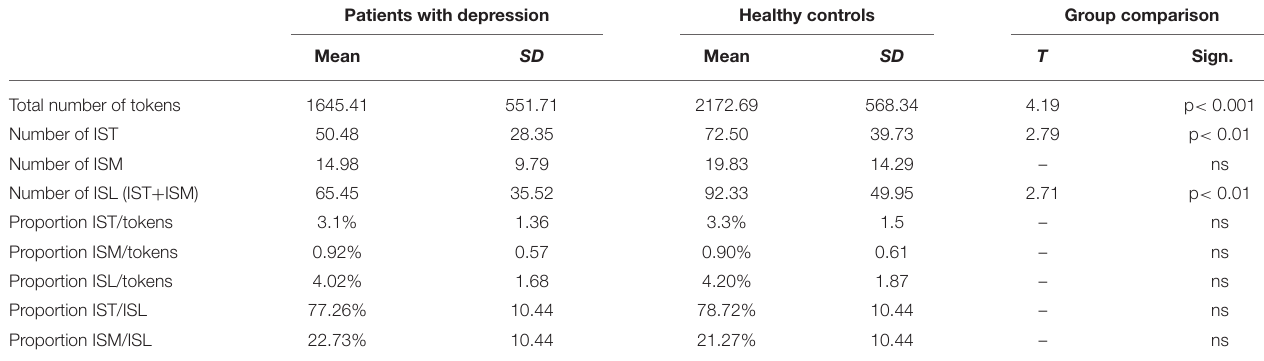
TABLE 2 | Group comparisons of the amount and composition of ISL in the elicited speech production task: absolute numbers and proportions. Patients with depression Healthy controls